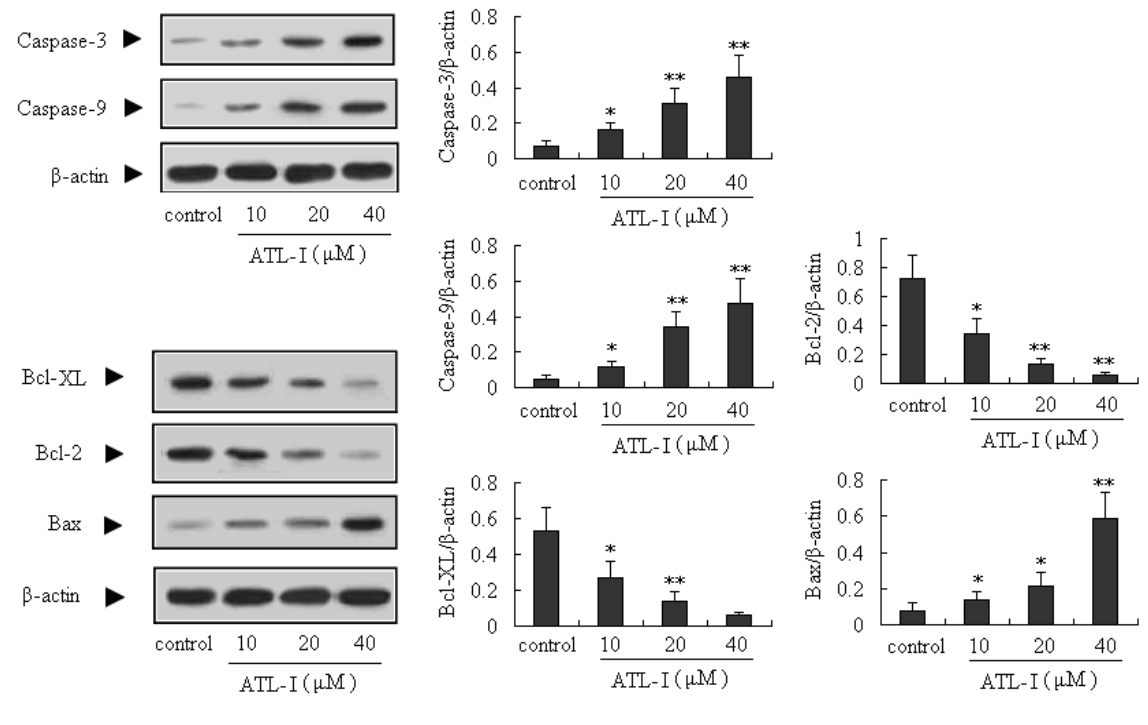
Figure 7. Effect of ATL-I on caspase-3, caspase-9, Bcl-XL, Bcl-2, and Bax expressions in HCC827 cells. Cells were treated with ATL-1 at concentrations of 10, 20, and 40 μ M for 48 hours, and the whole cell lysates were determined by western blot analysis using antibodies for caspase-3, caspase-9, Bcl-XL, Bcl-2, and Bax as indicated. All data were expressed as mean ± SEM (n = 3), * p < 0.05, ** p < 0.01, vs.